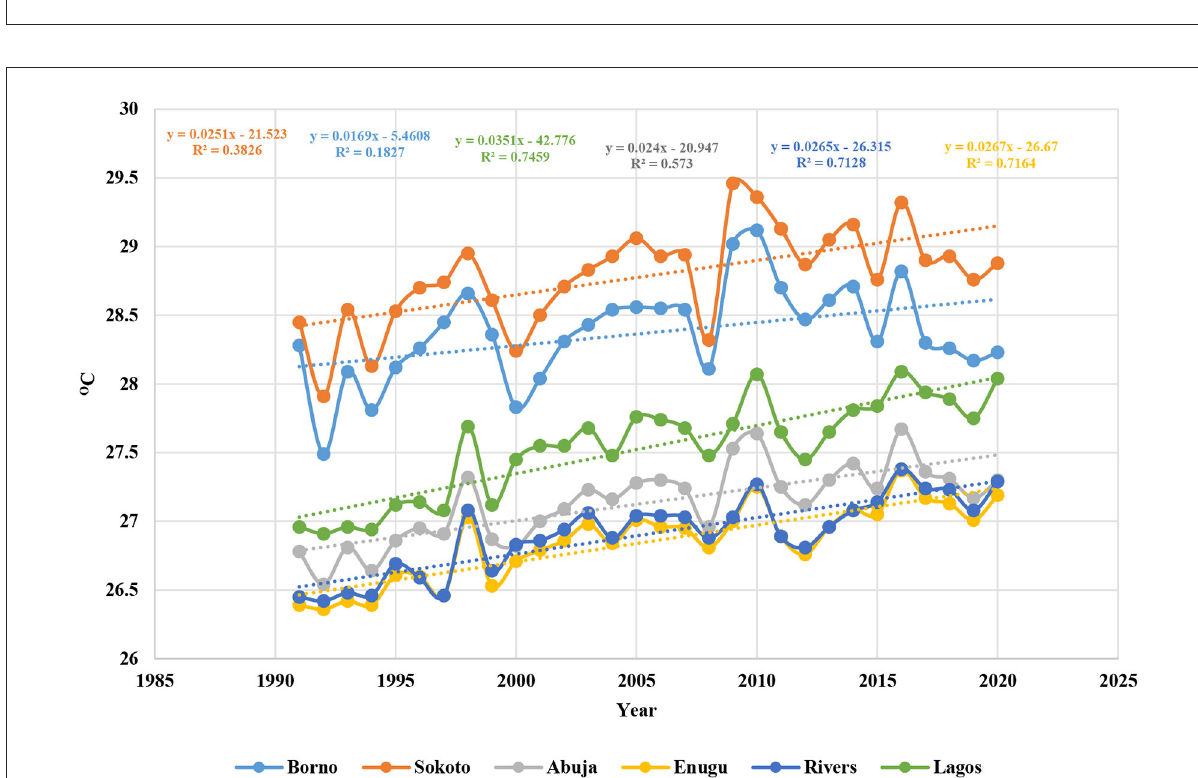
FIGURE6 Temperature distribution in Nigeria (1991–2020). Source: World Bank Climate Change Knowledge Portal